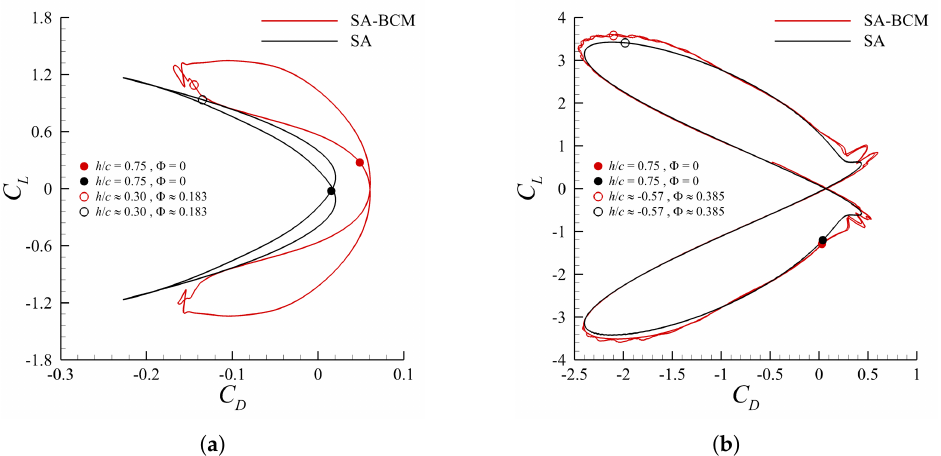
Figure 4. ( C L , C D ) phase diagram for α max = 15 ◦ using transition and fully turbulent model with St = 0.1 ( a ) and St = 0.45 ( b ). The curves cover a total of two time periods; solid circles ( • ) identify the starting point of the oscillating cycle and empty circles ( ◦ ) indicate the point where vorticity fields in Figure 5 are depicted.